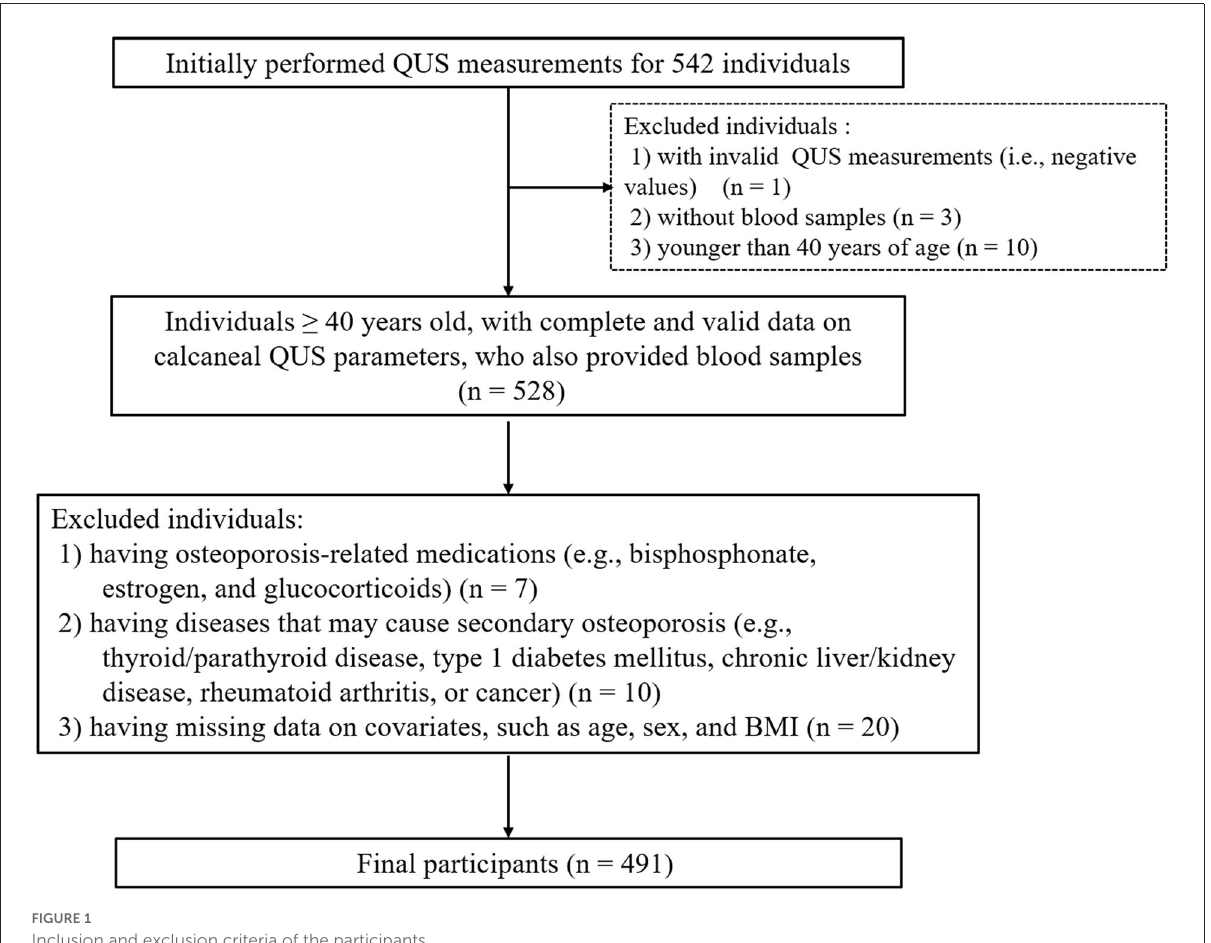
FIGURE1 Inclusion and exclusion criteria of the